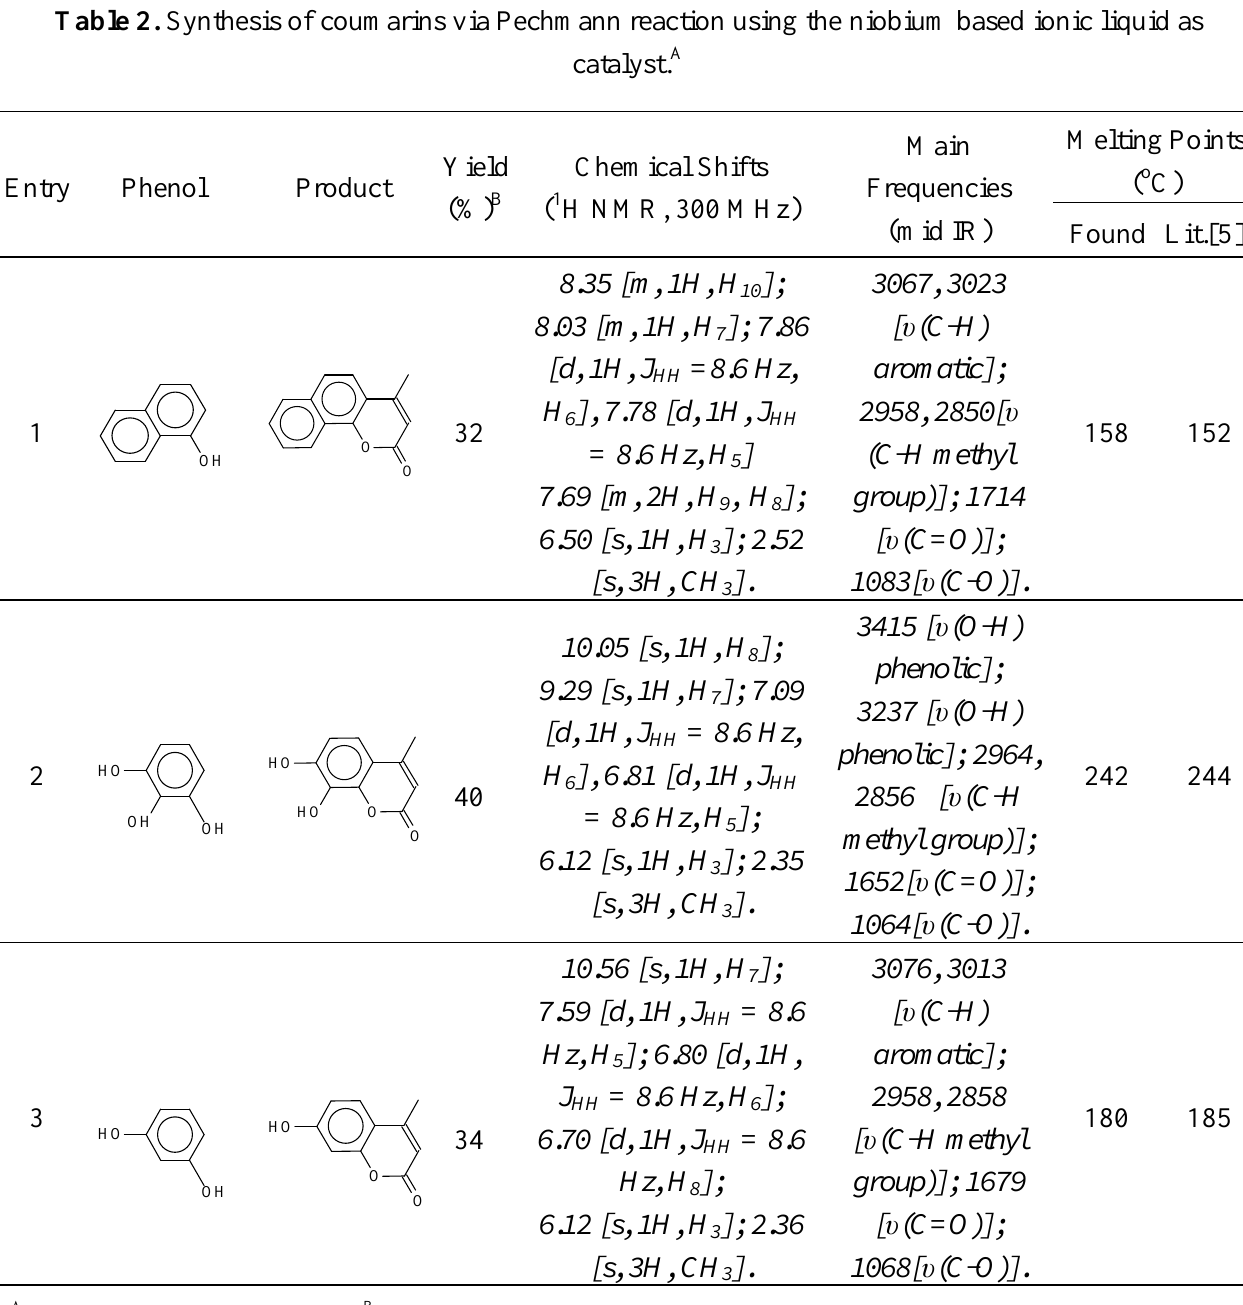
Figure 2. Pechmann`s reaction of α -naphthol with ethylacetoacetate in organo-niobate ionic mixture. Table 2. Synthesis of coumarins via Pechmann reaction using the niobium based ionic liquid